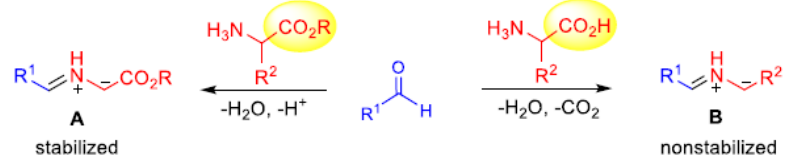
Figure 2. Azomethine ylides from amino esters or amino acid.